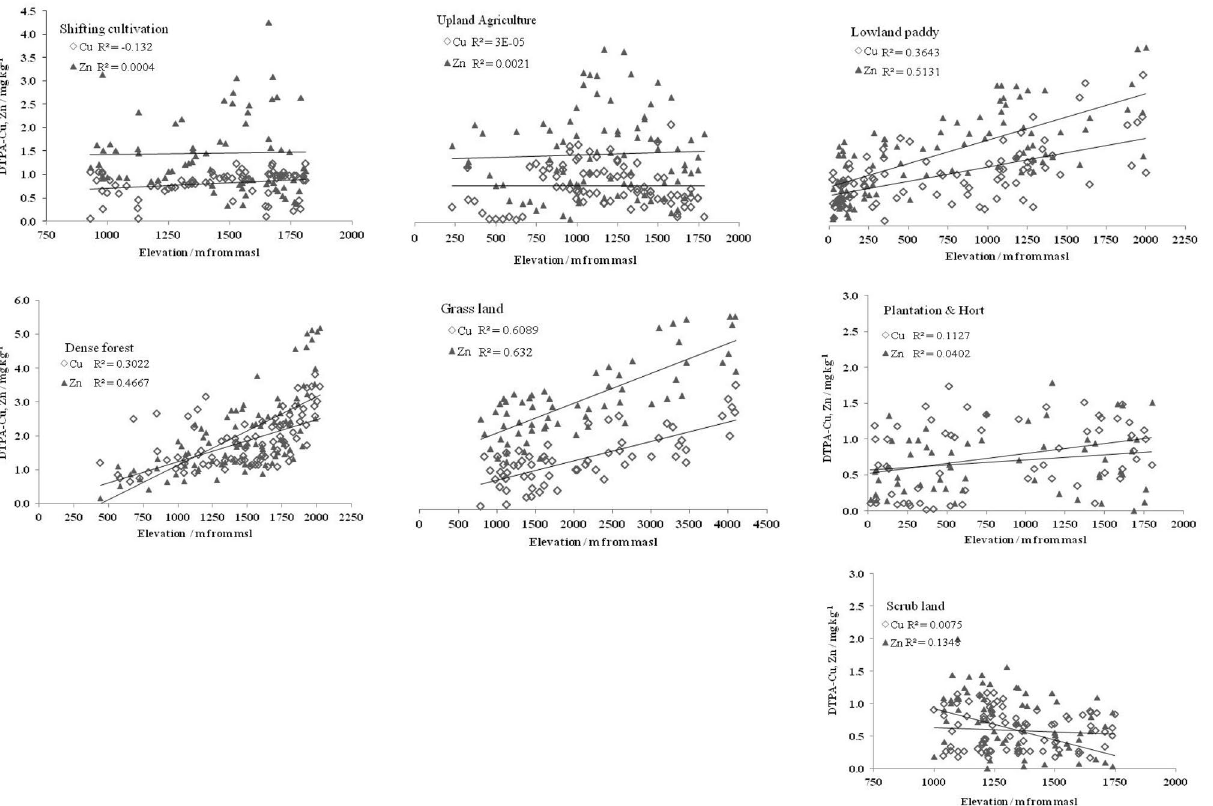
Figure 5. Effect of land uses on response of DTPA extractable Cu and Zn (mg kg -1 ) concentrations along the altitudinal gradients.